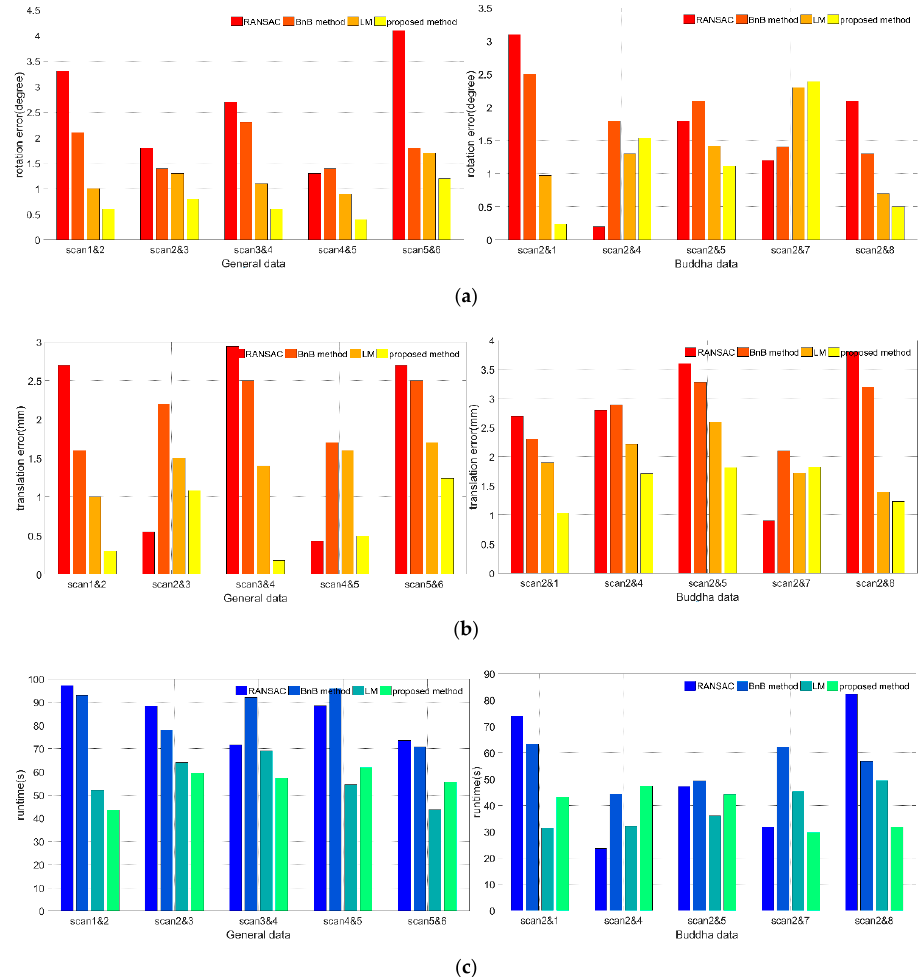
Figure 14. Comparison of the pairwise registration methods of General and Buddha: ( a ) rotation errors, ( b ) translation errors, ( c ) runtime.